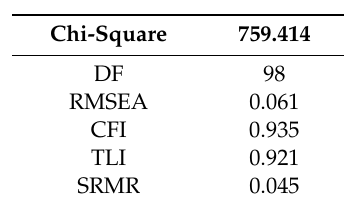
Table 3. The fit statistics for a confirmatory factor analysis of the 4 factor structurea of the Academic Behavioural Confidence